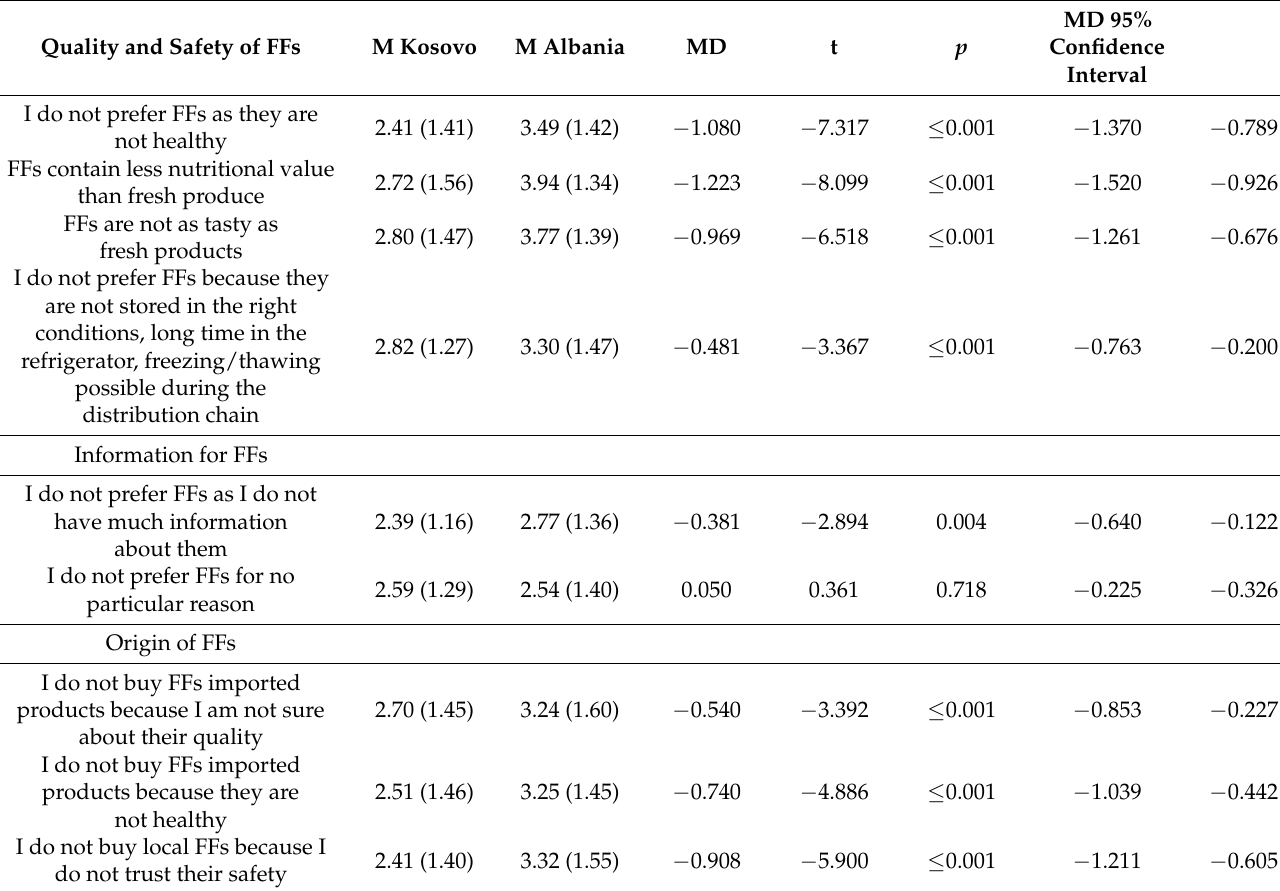
Table 2. Comparison of consumers’ perception on FFs between Kosovo and